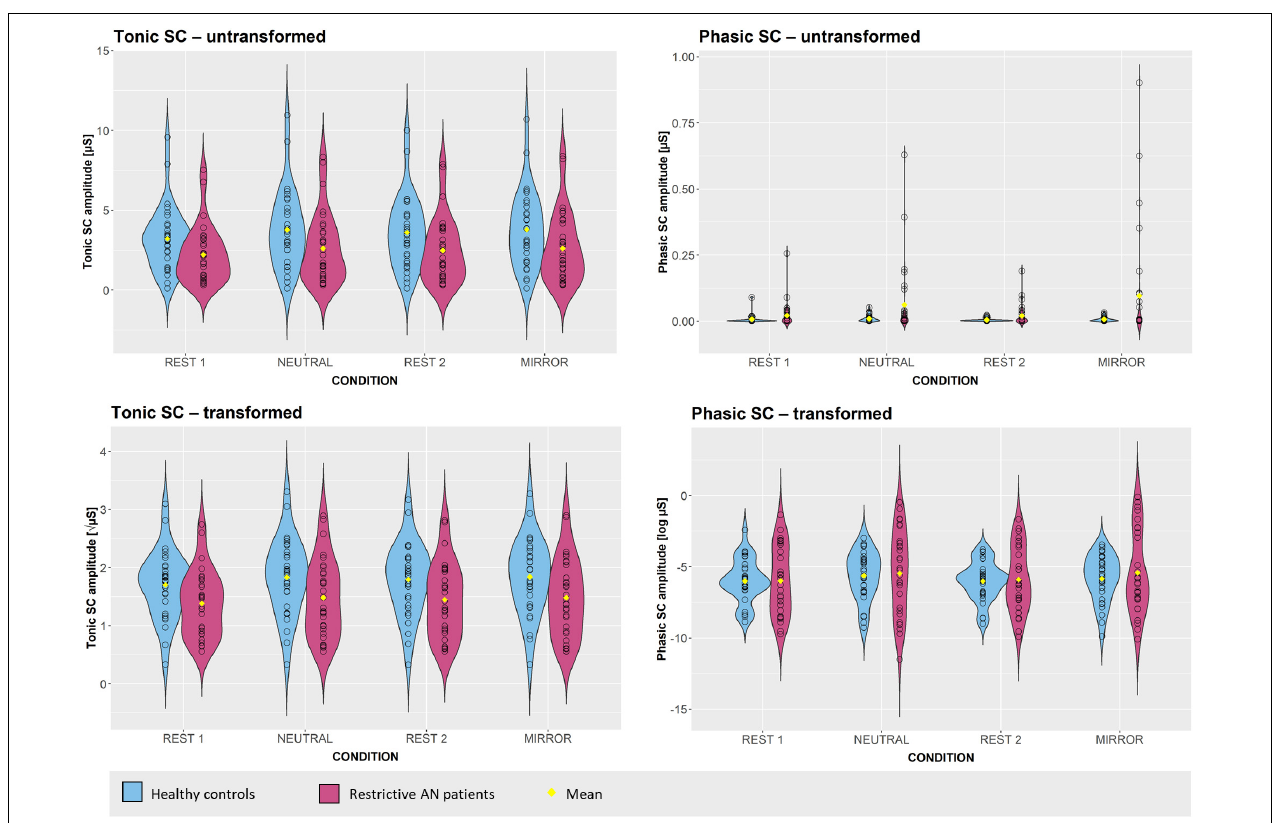
FIGURE 3 | Violin plots of electrodermal responses in AN patients and matched healthy controls across